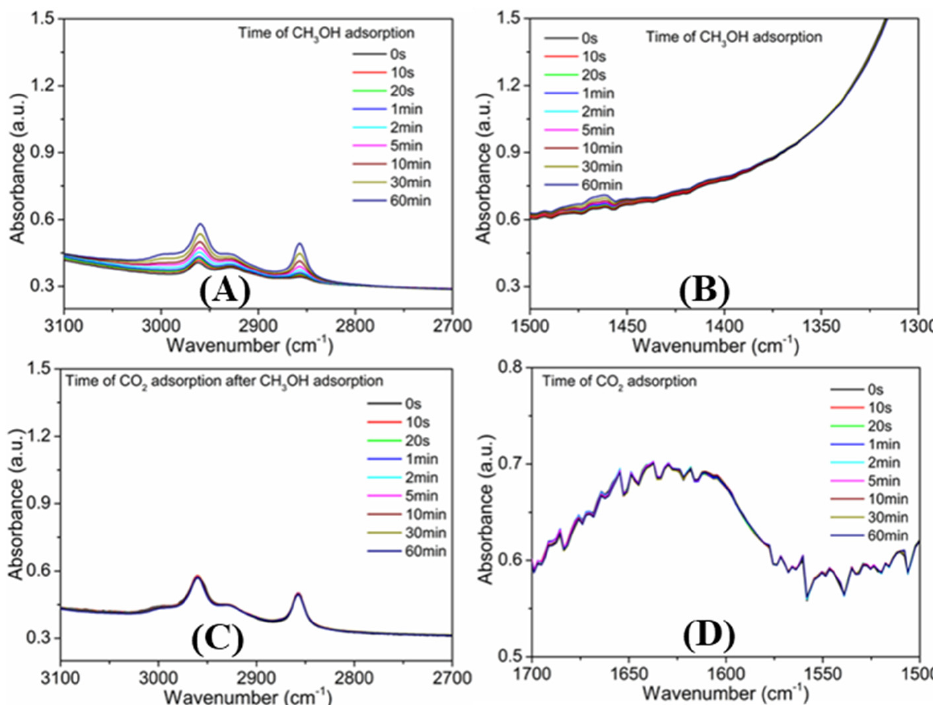
Figure 4. In situ FTIR spectra of CO 2 and CH 3 OH adsorption on SBA-15 in the regions of 2700 cm − 1 –3100 cm − 1 ( A ), in situ FTIR spectra of CO 2 and CH 3 OH adsorption on SBA-15 in the regions of 1300 cm − 1 –1500 cm − 1 ( B ), in situ FTIR spectra of CO 2 and CH 3 OH adsorption on SBA-15 in the regions of 2700 cm − 1 –3100 cm − 1 ( C ), in situ FTIR spectra of CO 2 and CH 3 OH adsorption on SBA-15 in the regions of 1500 cm − 1 –1700 cm − 1 ( D